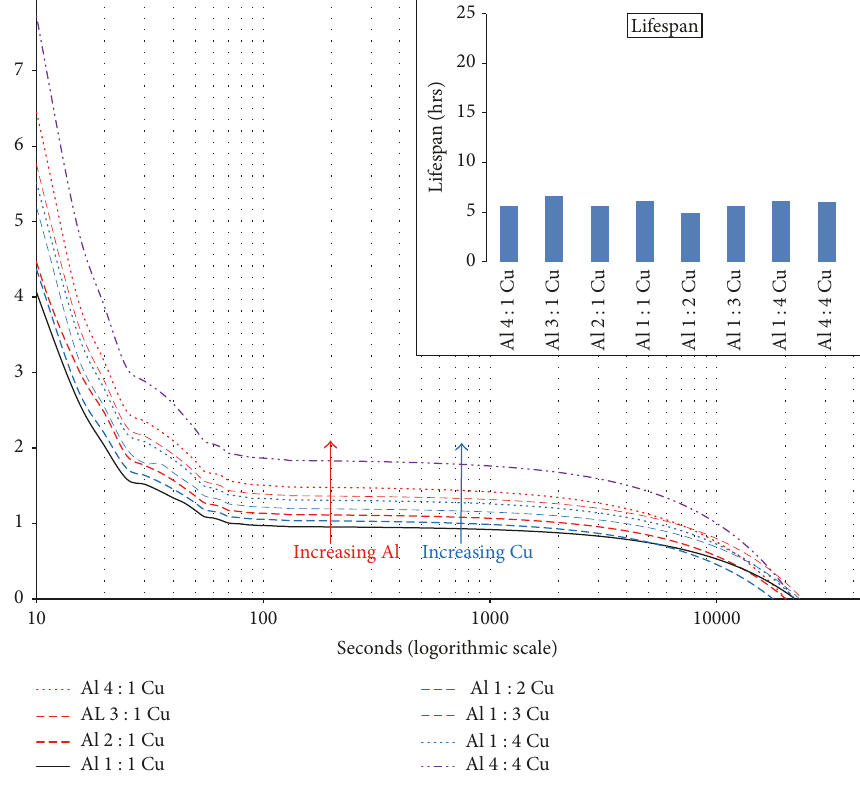
Figure 8: Current discharge curves across a 10 Ω resistor for different anode to cathode